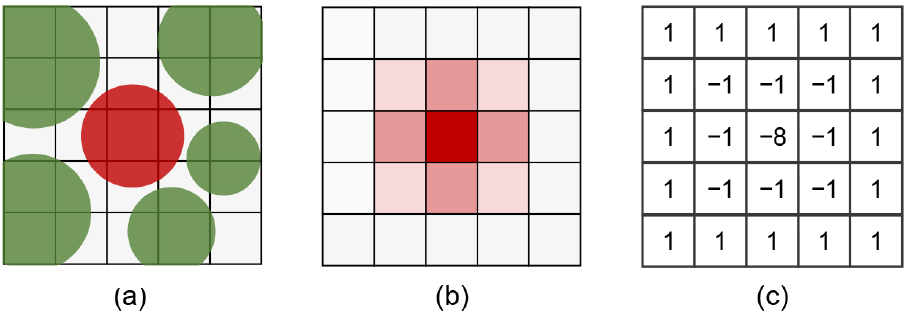
Figure 4. Typical spatial patterns of ( a ) a wilted pine tree on the ground and ( b ) the corresponding ∆ NGRDI in the satellite image, and ( c ) the proposed kernel matching the spatial pattern of the wilted pine trees. The canopy width is set to twice the pixel size as an example according to the average canopy width acquired from the in situ investigations and spatial resolution of the satellite image used in this study.